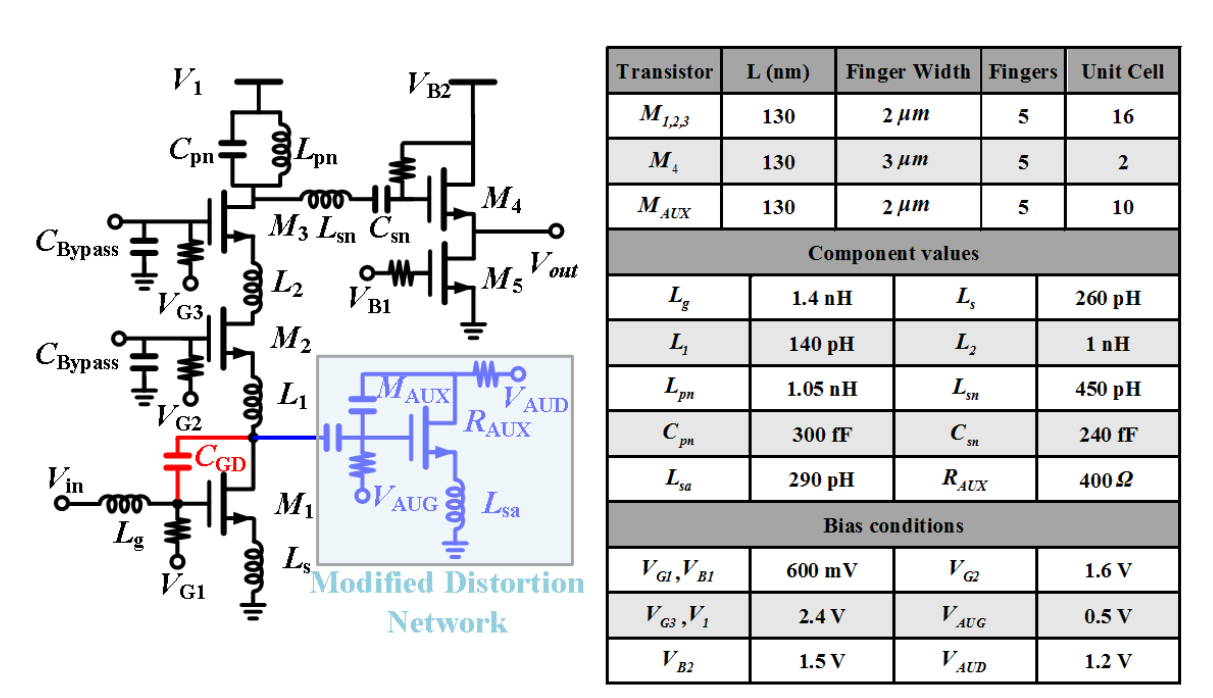
Figure 1. Schematic of the proposed triple-cascode LNA with the modified post-distortion network.